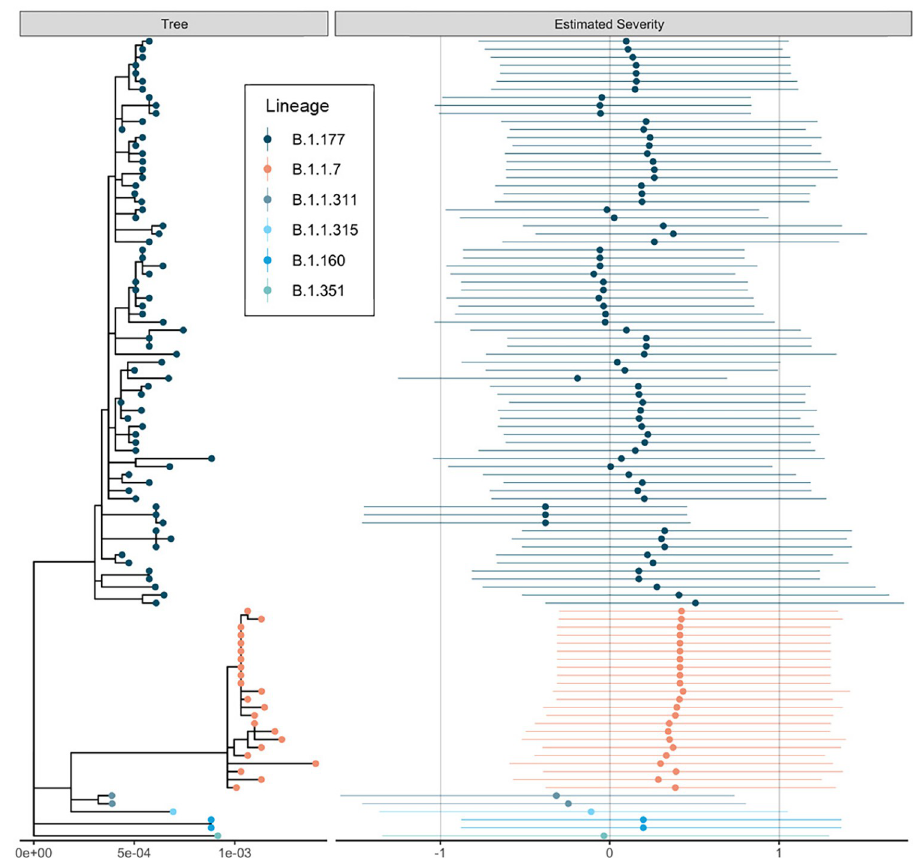
Fig 3. The estimated maximum likelihood phylogenetic tree and a measure of estimated severities of infection. Estimated severities for each viral isolate are means and 95% credible intervals of the linear predictor change under infection with that viral genotype from the phylogenetic random effect in the cumulative severity model under a Brownian motion model of evolution. This model constrains genetically identical isolates to have identical effects, so changes should be interpreted across the phylogeny rather than between closely related isolates which necessarily have similar estimated severities. The dataset was downsampled to 100 random samples for this figure to aid readability. Figure was generated using ggtree